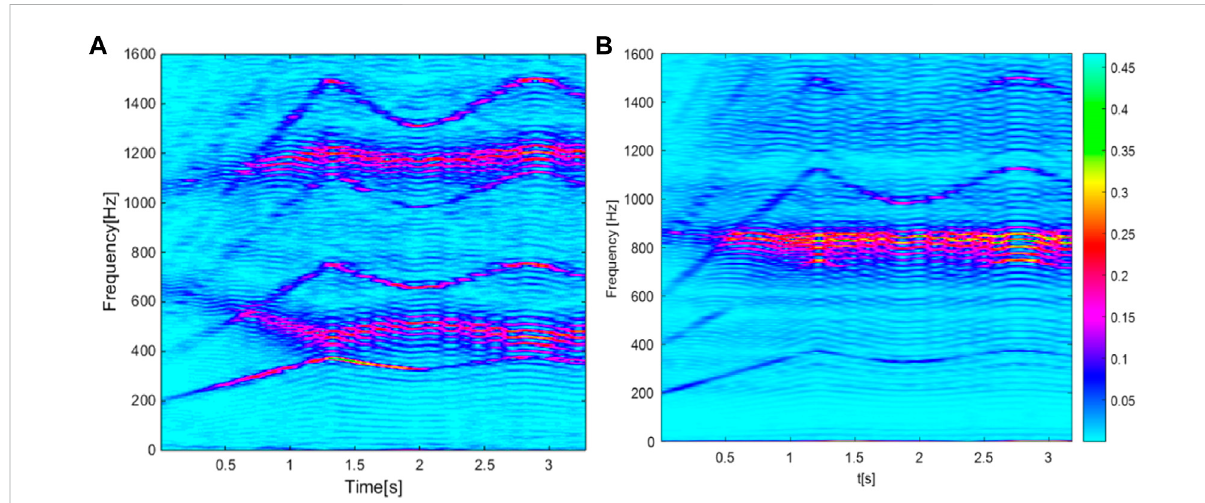
FIGURE 8 Comparison of the time – frequency distribution based on the STFT (A) and và WSST (B) .